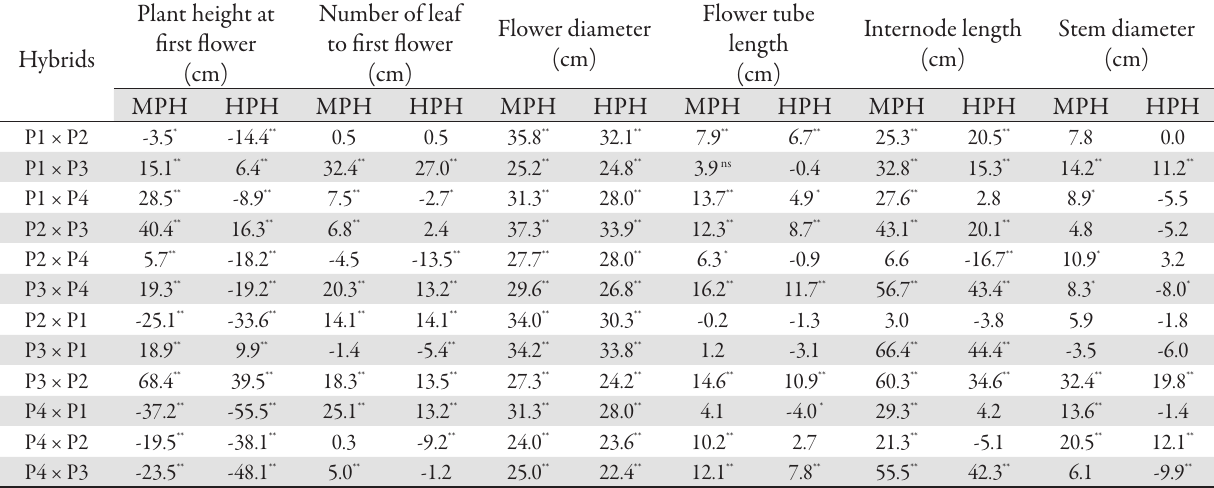
Tab. 5. Estimates of specific combining ability (SCA) and reciprocal (RE) effects of hybrids for plant height, plant spreading, number of branches per plant, leaf length and width in